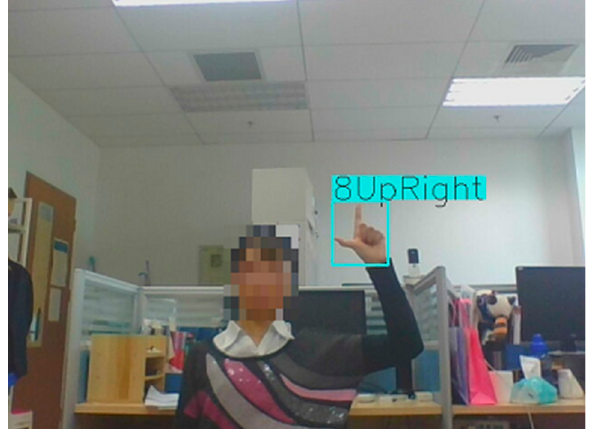
Figure 12. Result of recognition of hand postures in the lab. Appl. Sci. 2020 , 10 , x FOR PEER REVIEW